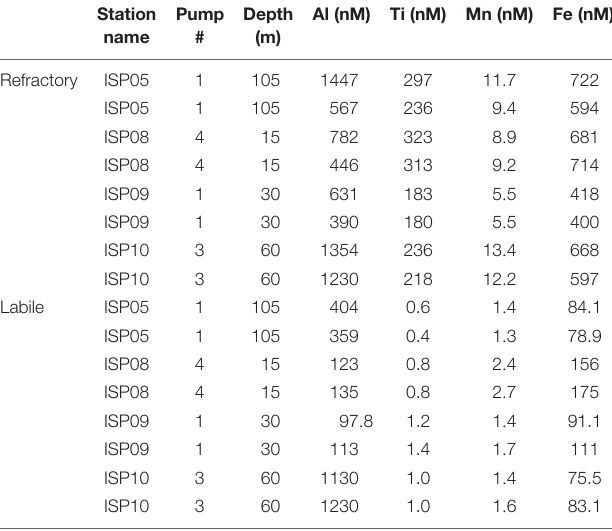
TABLE 2 | Duplicate subsamples from the in situ pump filters were subjected to the full sequential trace metal extraction and are shown to illustrate the full process error typical for the